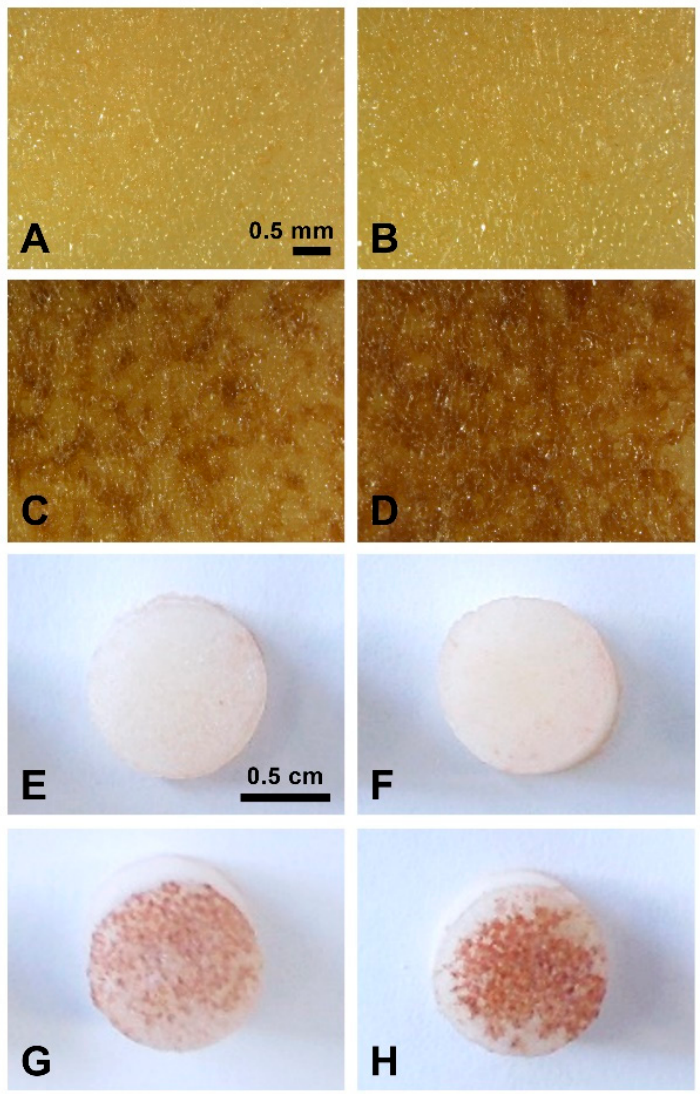
Figure 6. 2-Aminoindan-2-phosphonic acid (AIP) inhibits tuber tissue browning in RB tuber parenchyma. Treatments were performed on tuber slices ( A – D ) or tuber discs ( E – H ). ( A , E ) Treatment with AIP (10 µM); ( B , F ) treatment with MeOH; ( C , G ) treatment with TA (5 µM) in combination with AIP (10 µM); ( D , H ) treatment with TA (5 µM). Pictures were taken 5 days after treatment and are representative of 3 tests.